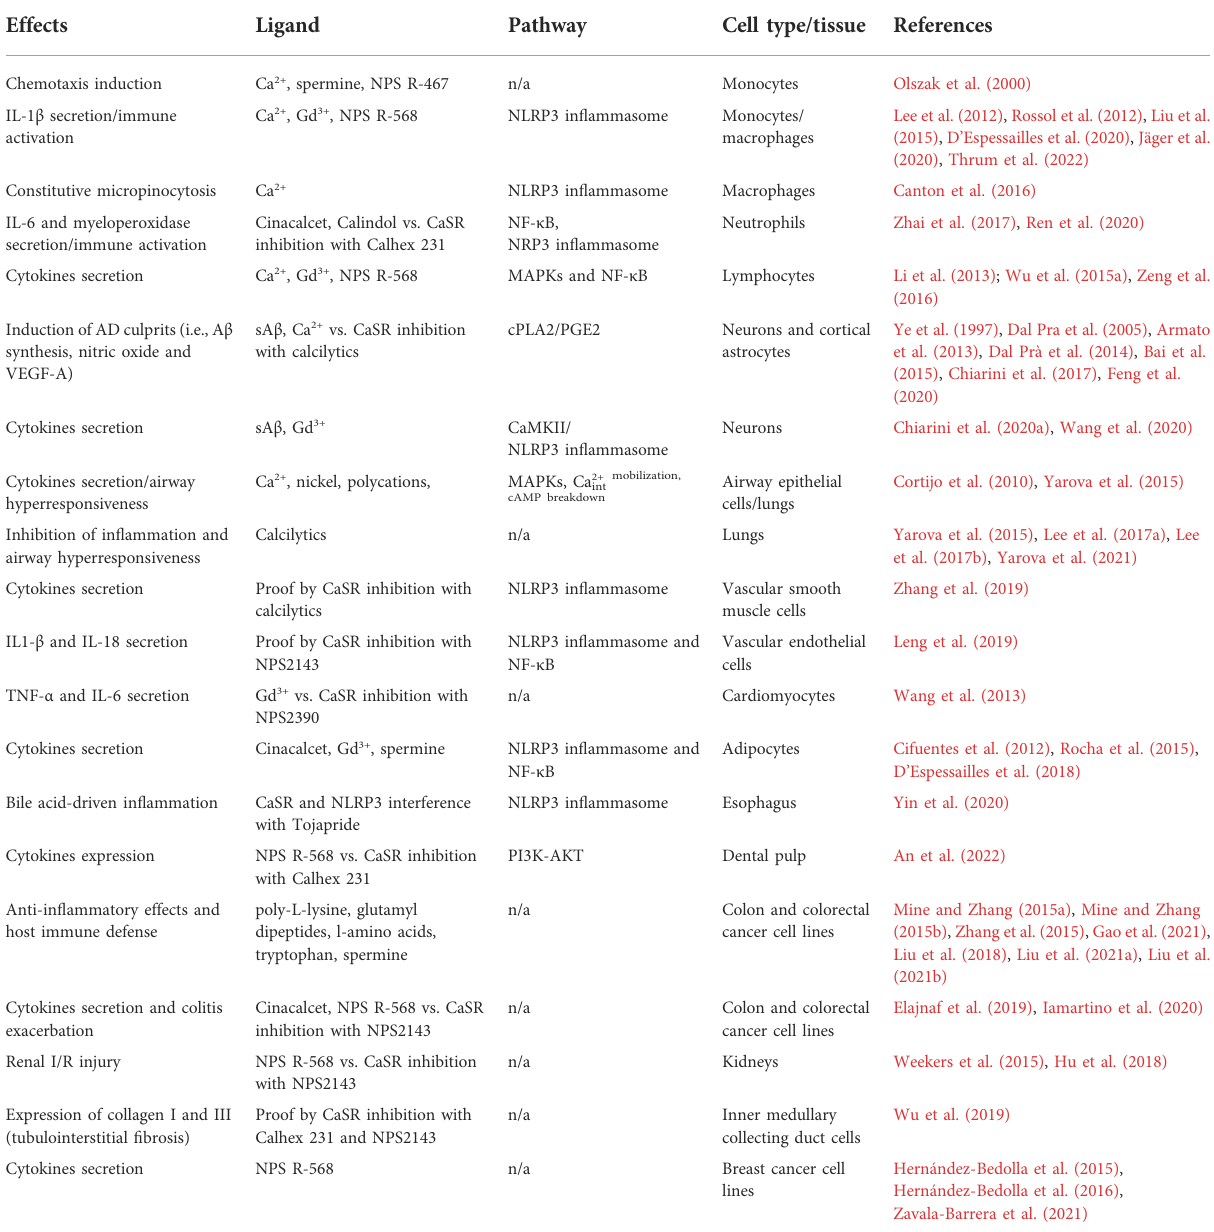
TABLE 1 CaSR-driven pro-in fl ammatory signals in different tissues and cell